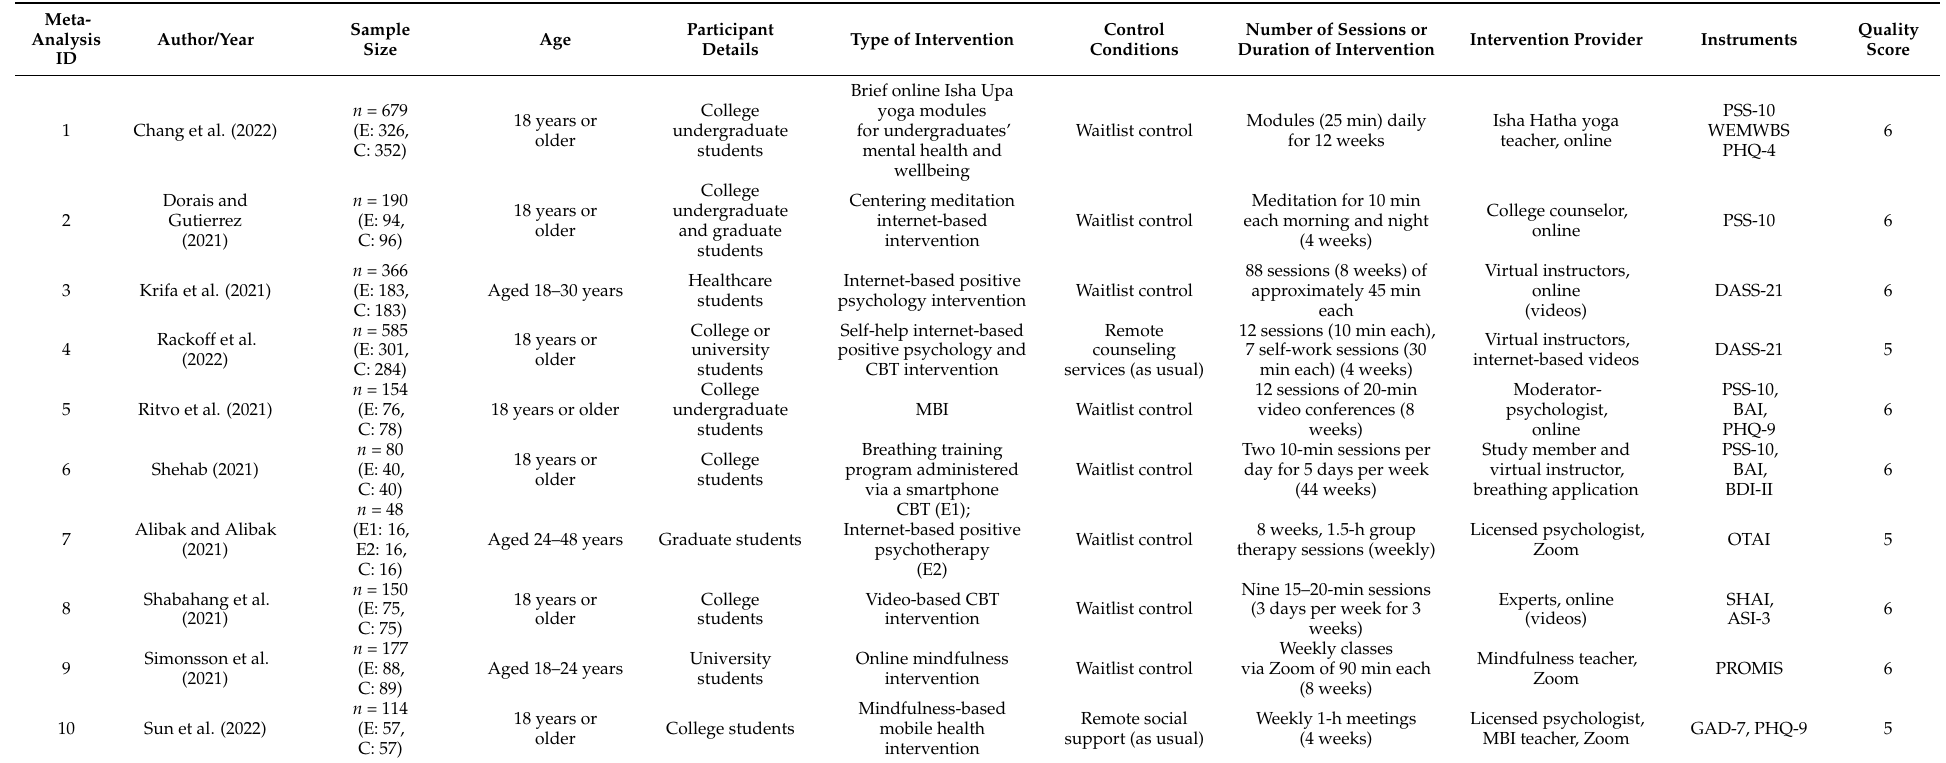
Table 1. Detailed descriptions of the reviewed